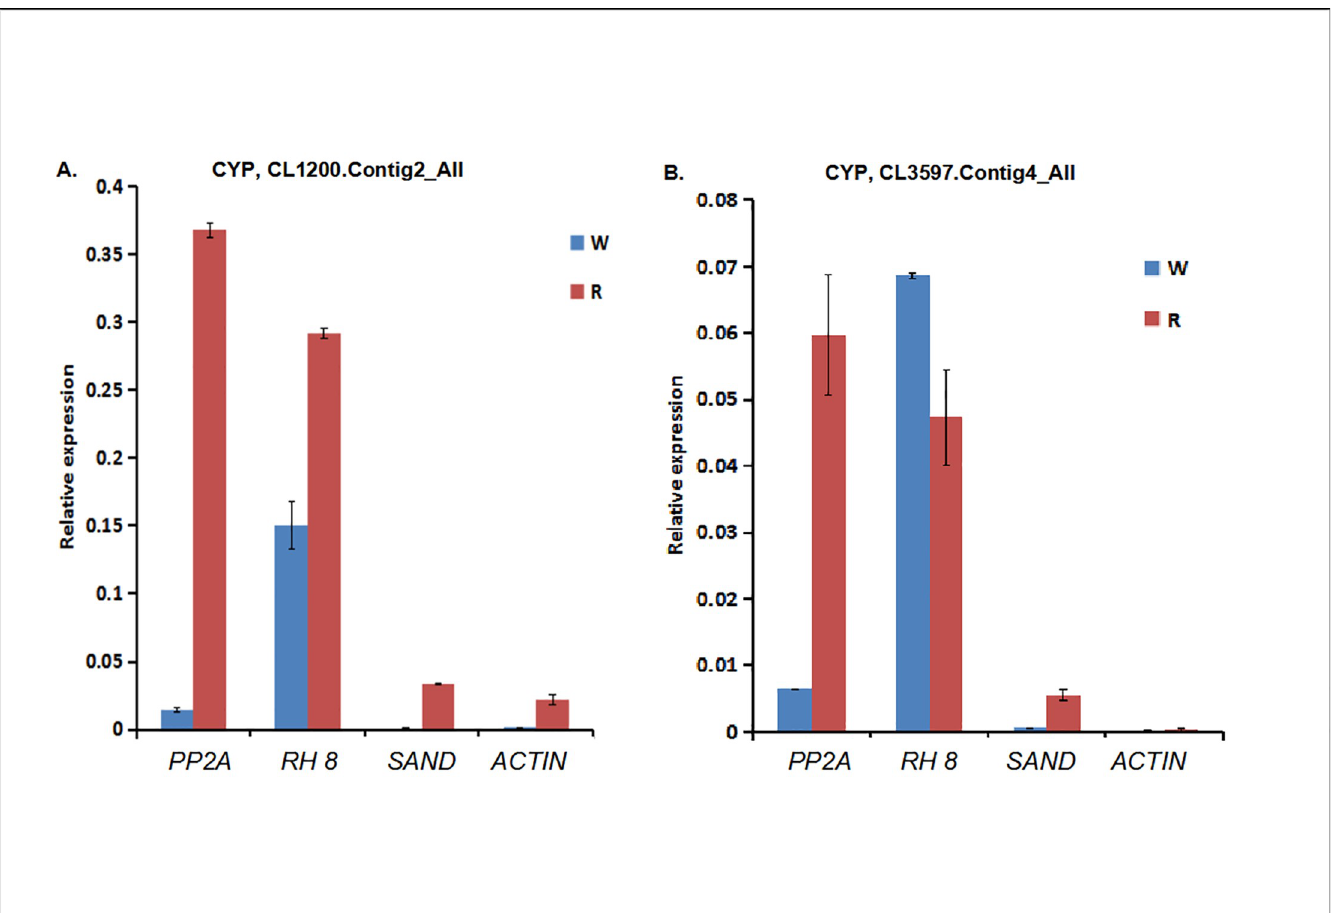
Fig 4. Relative expression profiles of CYPs in between white (W) and red (R) fruits in cranberry normalized by PP2A , RH 8 , SAND and ACTIN , respectively. CL1200.Contig2_All; (B) CL3597.Contig4_All.